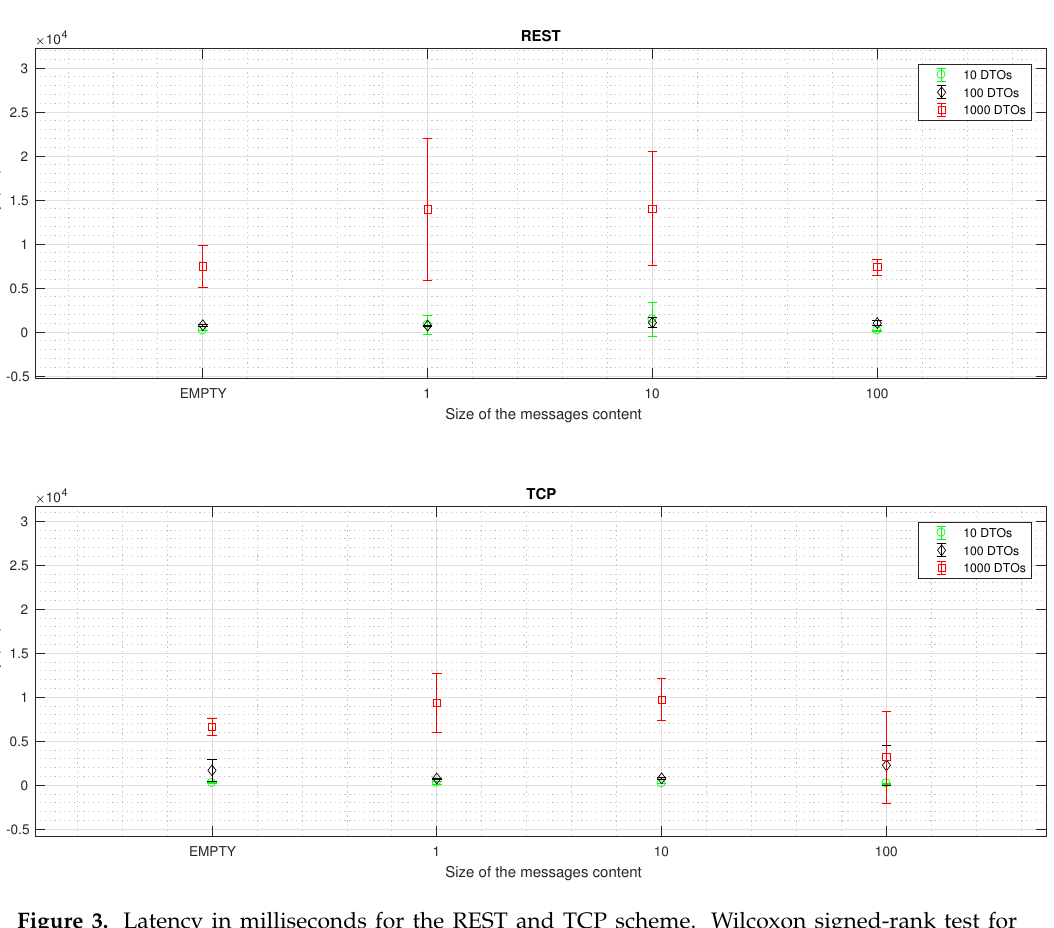
Figure 3. Latency in milliseconds for the REST and TCP scheme. Wilcoxon signed-rank test for a C.I. = 95% confirms statistical significant difference for each intra ( p < 0.05) and inter scheme ( p < 0.01)